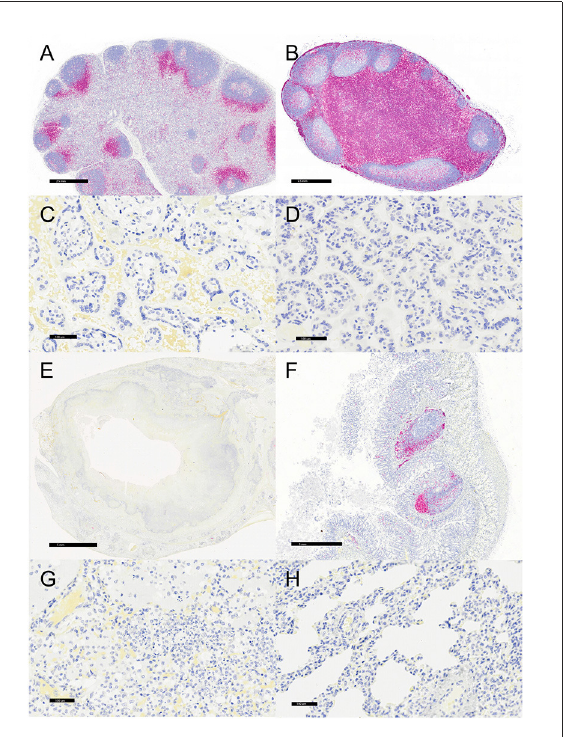
FIGURE6 Immunohistochemistry for CD3, vervets, multiple organs. (A) Y. enterocolitica- positive vervet, mesenteric lymph node, case 6. Few CD3-positive cells are present within the lymph node medulla, with the remaining cells confined to perifollicular regions of the cortex. (B) Control vervet, mesenteric lymph node. Greater than 90% of cells within the lymph node are CD3-positive T cells. (C) Y. enterocolitica- positive vervet, placenta, case 20. CD3-positive T cells are absent in the placenta from a Y. enterocolitica- positive vervet. (D) Control vervet, placenta. CD3-positive T cells are absent from a gestational date-matched control in the placenta. (E) Y. enterocolitica- positive vervet, colon, case 3. CD3-positive T cells are absent from colonic sections as lesions effaced gut-associated lymphoid tissue. (F) Control vervet, colon. CD3-positive lymphocytes are present within gut-associated lymphoid tissue and colonic mucosa. (G) Y. enterocolitica- positive vervet, lung, case 1. CD3-positive T cells are absent in lung sections. (H) Control vervet, lung. T cells are also absent in an age-matched area of control